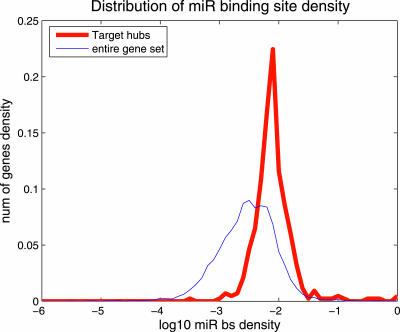
Distribution of the density of miRs in the 3′ UTRs of target hubs (thick red line) and all the genes (thin blue line) in the TargetScan dataset (all genes included in this figures have at least one miR site predicted in their 3′ UTR). The log10 densities were binned into bins of 0.1, and relative frequencies were plotted. Same analysis for the PicTar dataset is in Figure S2.